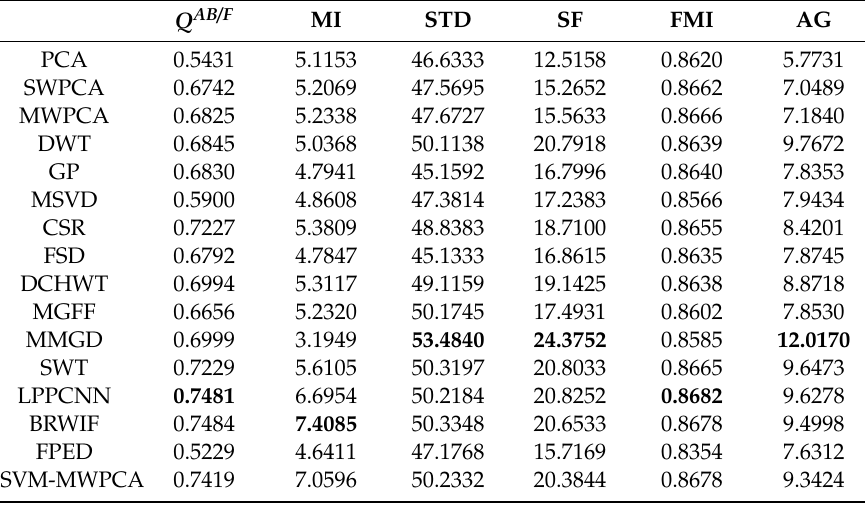
Table 3. Evaluation indexes of the fused images in source image pair